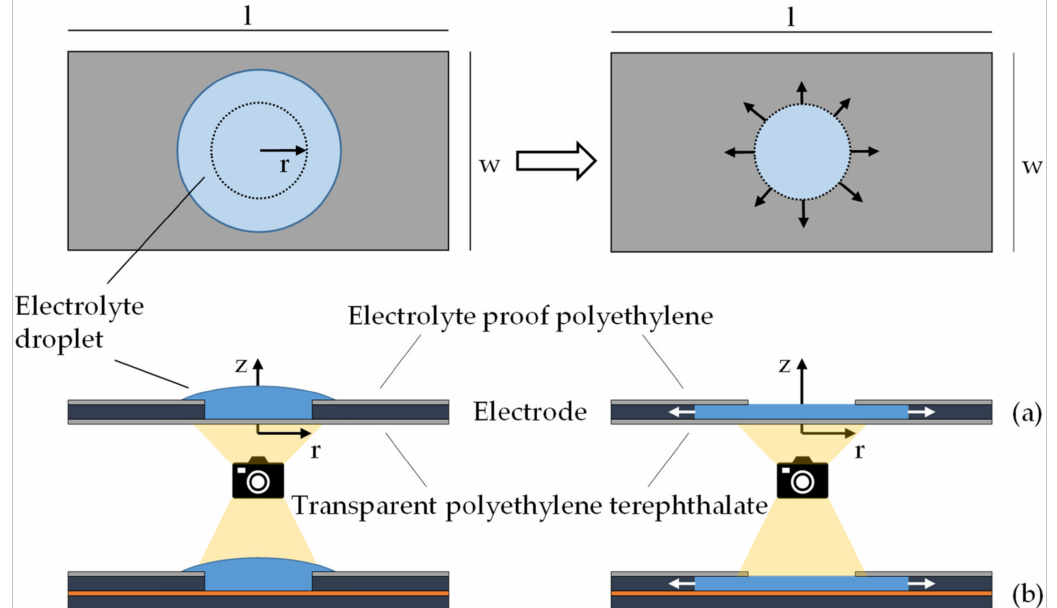
Figure 9. ( a ) Illustration of the measurement method used in the publication by Davoodabadi et al.; ( b ) an extension of the method for double-sided coated electrodes.